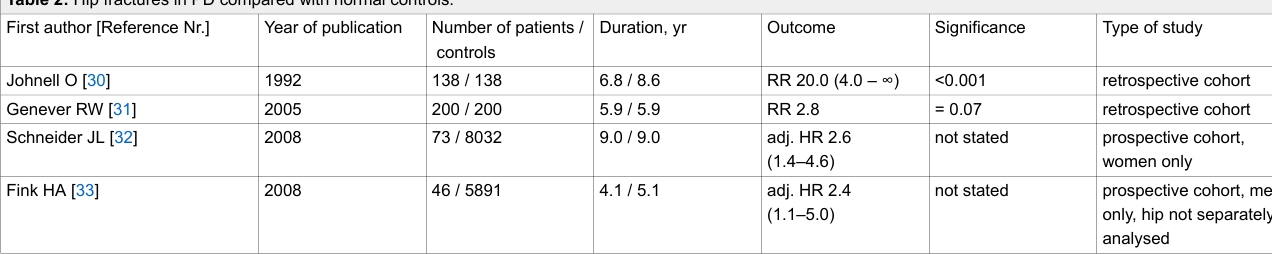
Table 2: Hip fractures in PD compared with normal